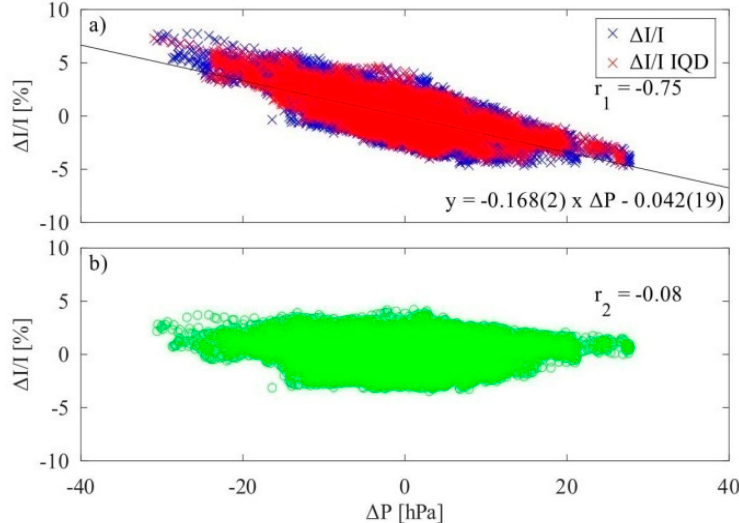
Figure 6. Determination of the barometric coefficient for the data recorded by the TOP detector. ( a ) Relative deviation of muon count rate as a function of pressure deviation for all data (blue markers) and for International Quiet Days (IQD) data—red markers. The correlation coefficient between the IQD data and the pressure variations was r 1 = − 0.75. Obtained barometric coefficient β P = − 0.168 %/hPa. ( b ) Pressure corrected data; correlation coefficient reduced to r 2 = −